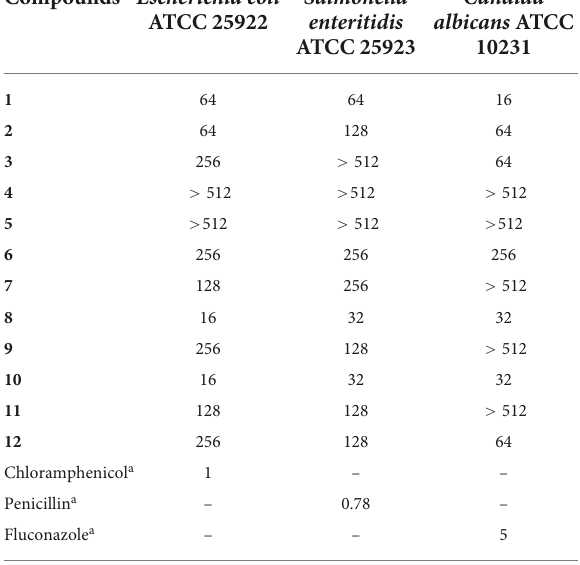
TABLE 5 Antimicrobial activity from Compounds 1 – 12 (MIC, µ